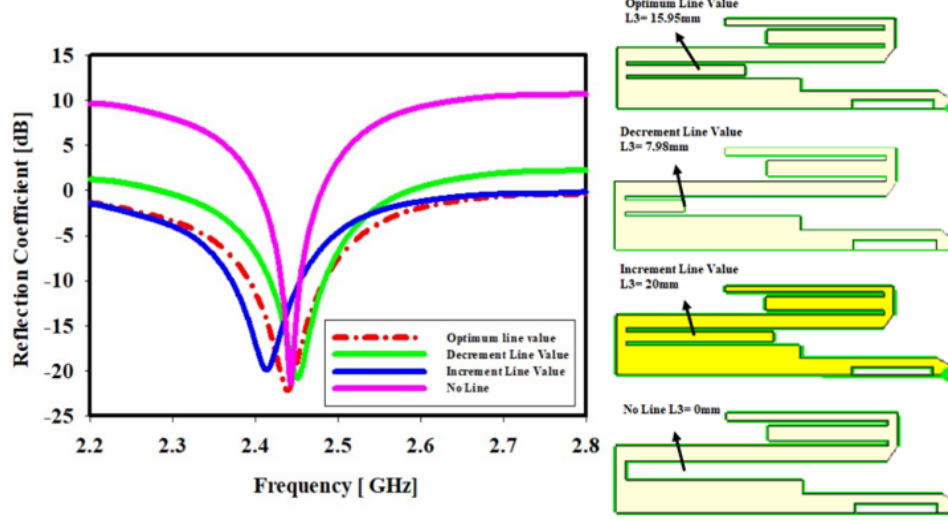
Figure 6. The effect of the middle − lower meander line length on the simulated reflection coefficient and the geometric of the lower ML length; the sketches on the most ‐ right side in Figure 6 show the geometries of the meander line changes.